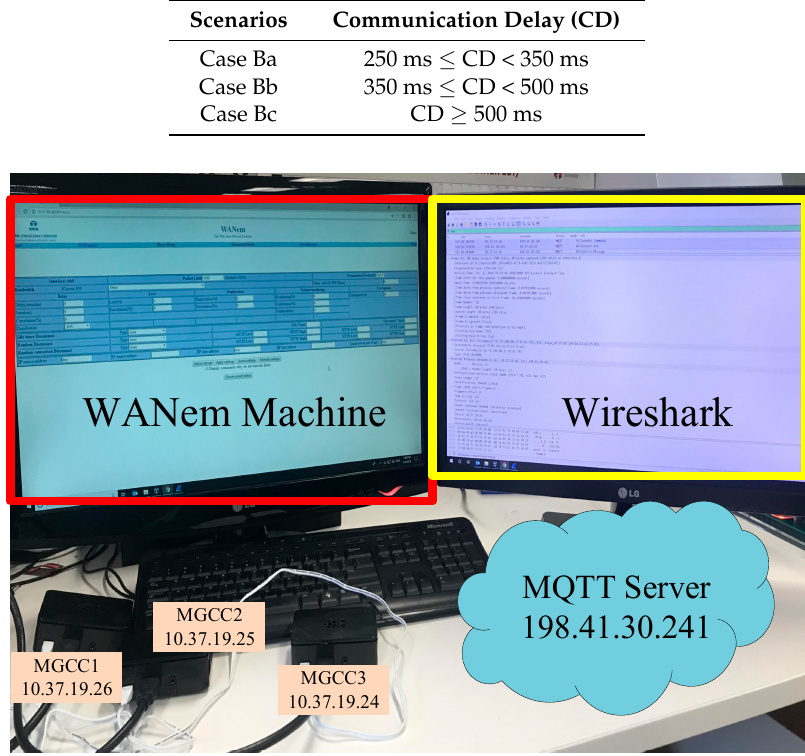
Figure 17. Communication delay implementation.